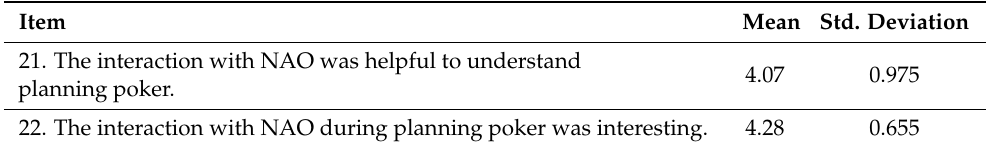
Table 4. Item statistics related to the quality of interaction with the robot NAO, n = 46. Rating on a five- point scale: “Strongly Agree” (5), “Agree” (4); “Neutral” (3); “Disagree” (2); ”Strongly Disagree” (1). Item Mean Std.